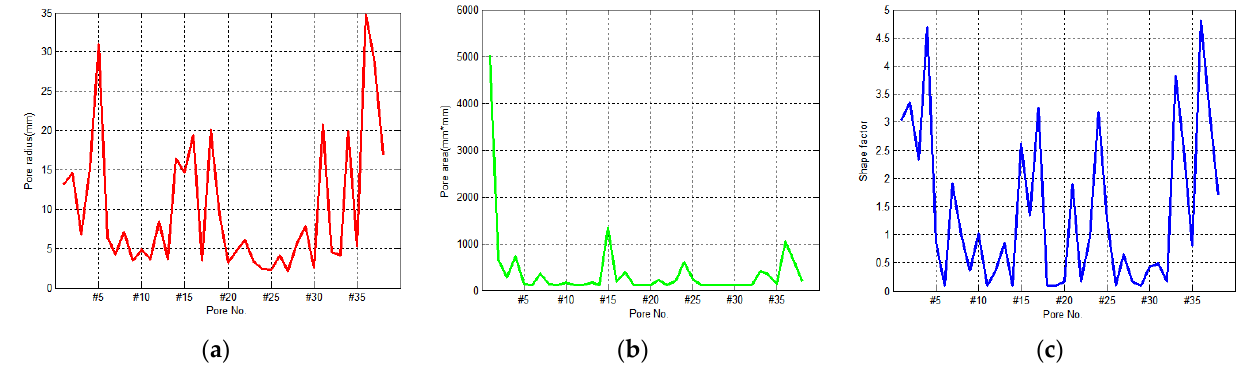
Figure 7. Plots of the karst pore structure parameters: ( a ) pore radius distribution, ( b ) pore area distribution, and ( c ) shape factor distribution.